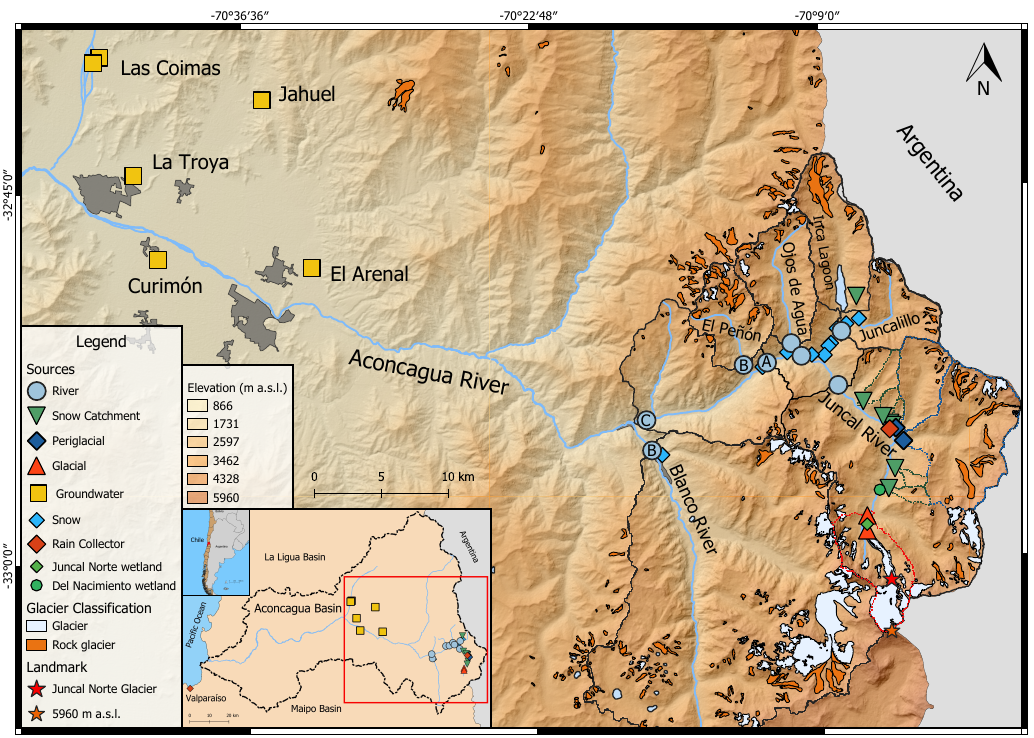
Figure 1. Study area digital elevation model, sampling sites and ice bodies. A, B and C refer to the sub-basins outlet location considered in the “simmr” model